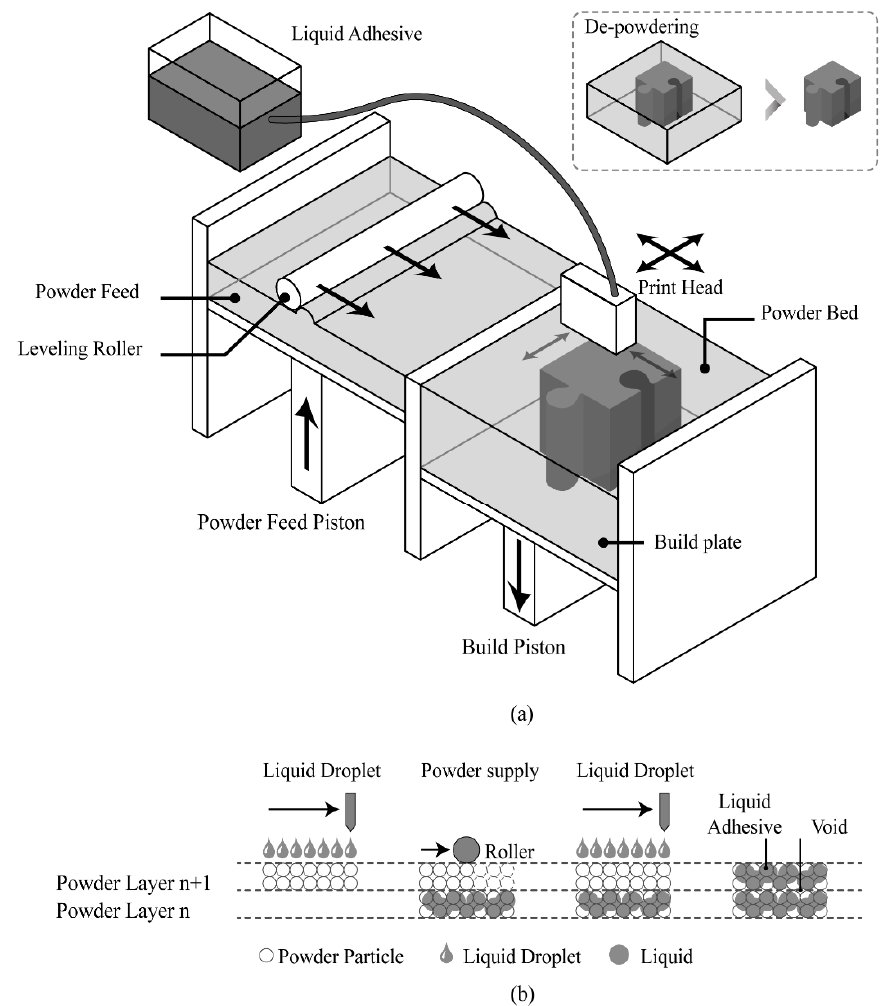
Figure 1. Schematic illustrations of binder jetting 3D printing (BJ3DP): ( a ) BJ3DP system and ( b ) powder/binder interaction between adjacent layers. Adapted with permission from ref. [32]. Copyright 2021 Kwang-min Park.